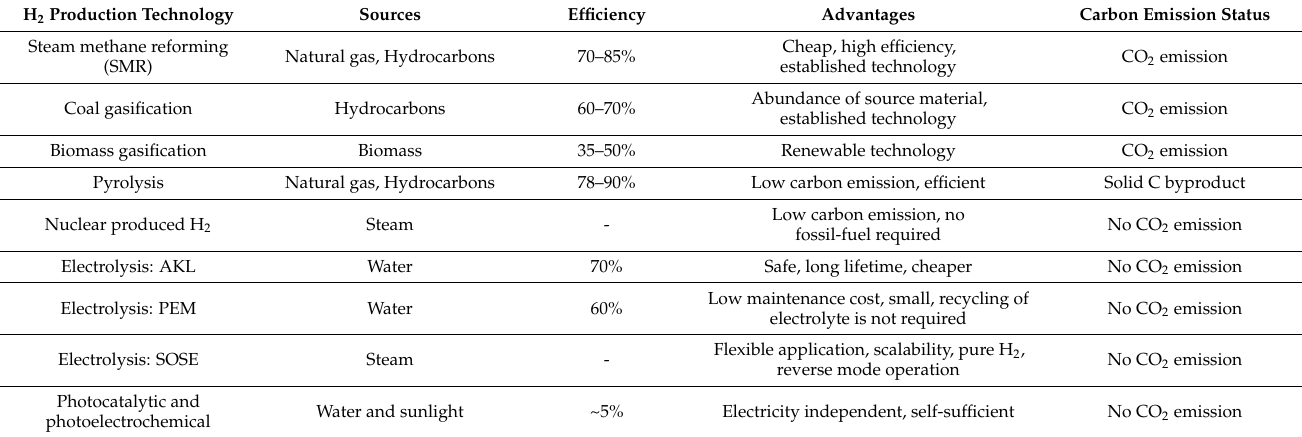
Table 1. Summary of H 2 production